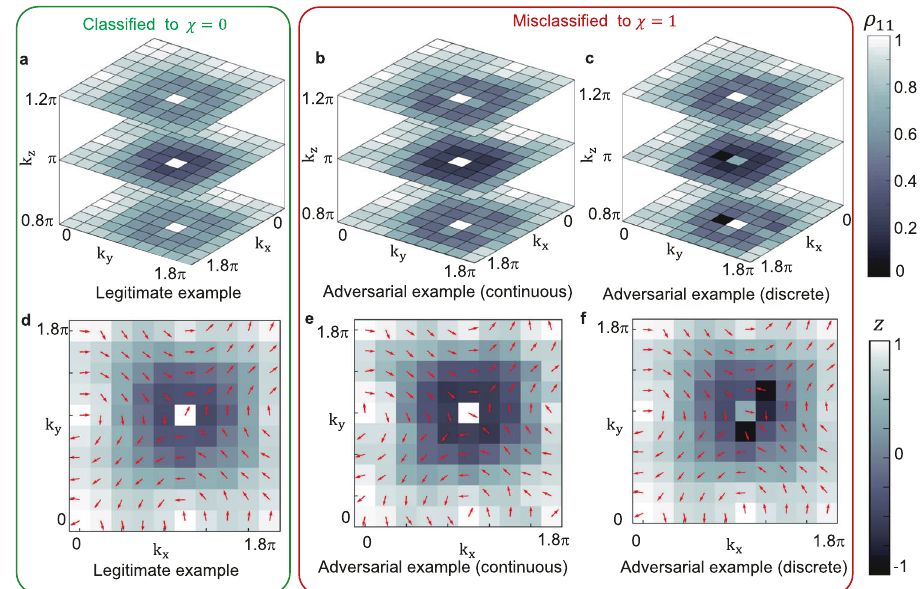
Fig. 3 | Visualization of experimentally realized density matrices for the Hopf insulatorswithh= 3.2.a – c The fi rstcomponent'smagnitude of theinput datafor h =3.2at k z =0.8 π , π and 1.2 π . a Legitimate sample with h =3.2 implemented inthe experiment. b Adversarial examples realized in the experiment with continuous perturbations generated by the projected gradient descent method. The average fi delity between the experimentally implemented adversarial examples and legit- imate samples is over 98%. c Adversarial examples realized in the experiment with discrete perturbation generated by the differential evolution algorithm. Among 1000 density matrices as input, only seven of them have been changed and